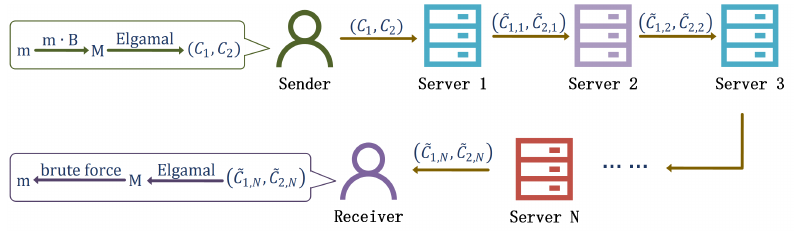
Figure 1. A simple illustration of the KS